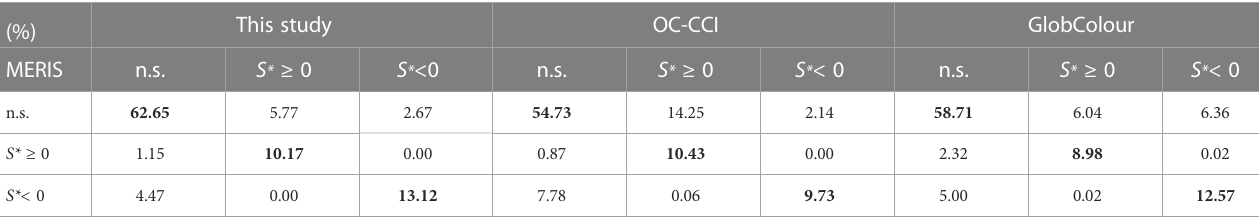
TABLE 2 Contingency matrices comparing trend analysis outcomes for MERIS